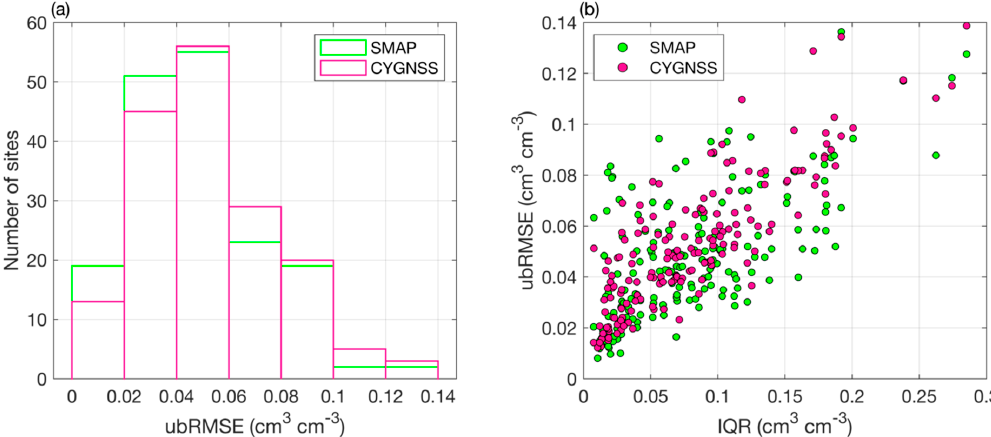
Figure 15. ( a ) Histograms of ubRMSE statistics for CYGNSS and in-situ observations (pink) and SMAP and in-situ observations (green). ( b ) The relationship between the interquartile range (IQR) of soil moisture at individual stations and the ubRMSE between CYGNSS and observations from that station (pink) and SMAP and observations from that station (green).